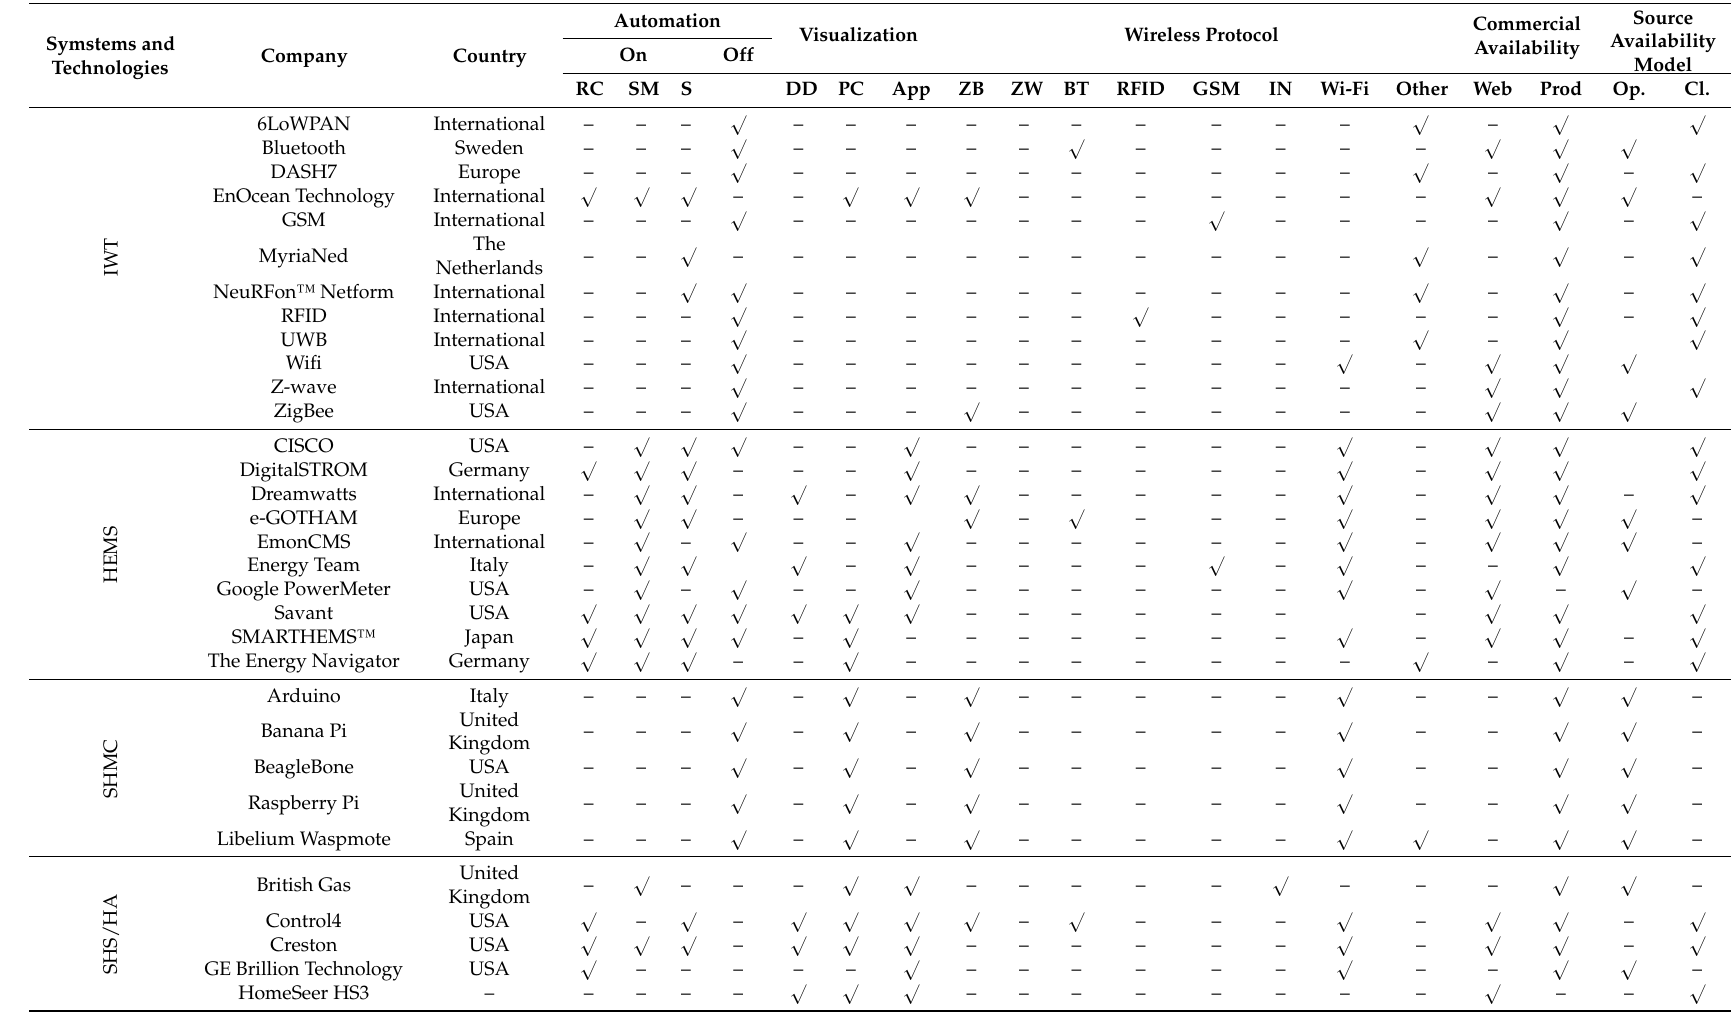
Table 1. Summary of the analyzed smart home